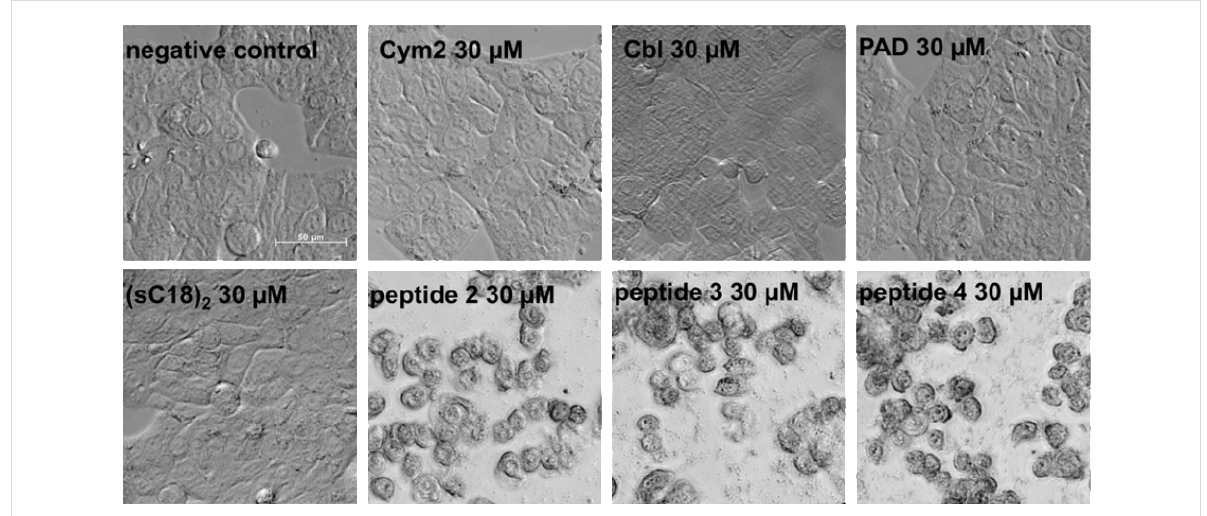
Figure 8: Brightfield microscopic images of unfixed HT-29 cells after 24 h incubation with the (sC18) 2 conjugates at 30 µM. Scale bar: 50 µm.